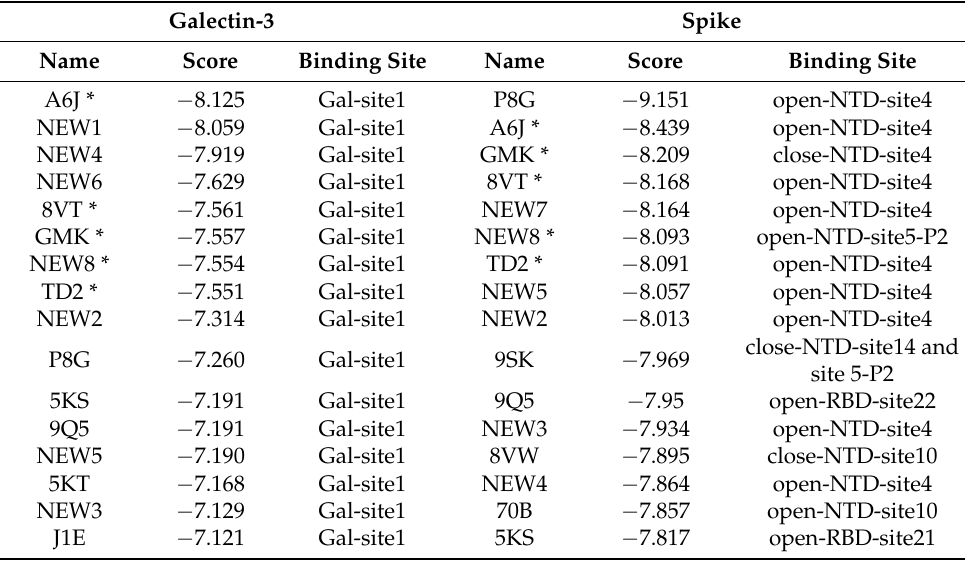
Table 4. Selected top-ranked inhibitors for Galectin-3 and Spike proteins. Dual inhibitors are indicated by an asterisk (*).